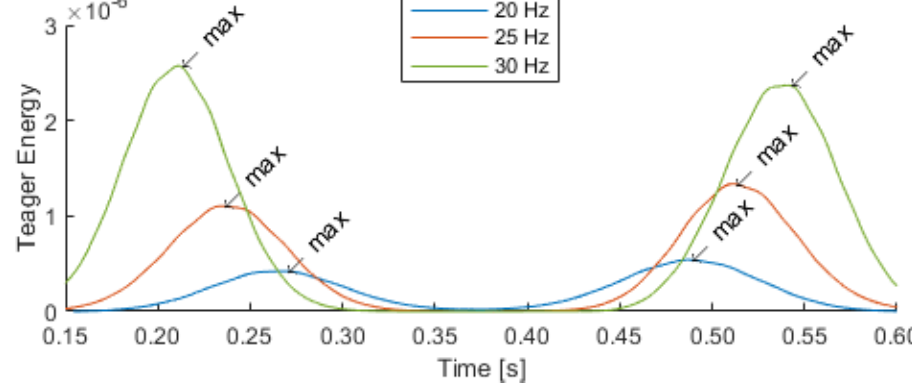
Figure 8. Teager energy at different frequencies (Rotor 2